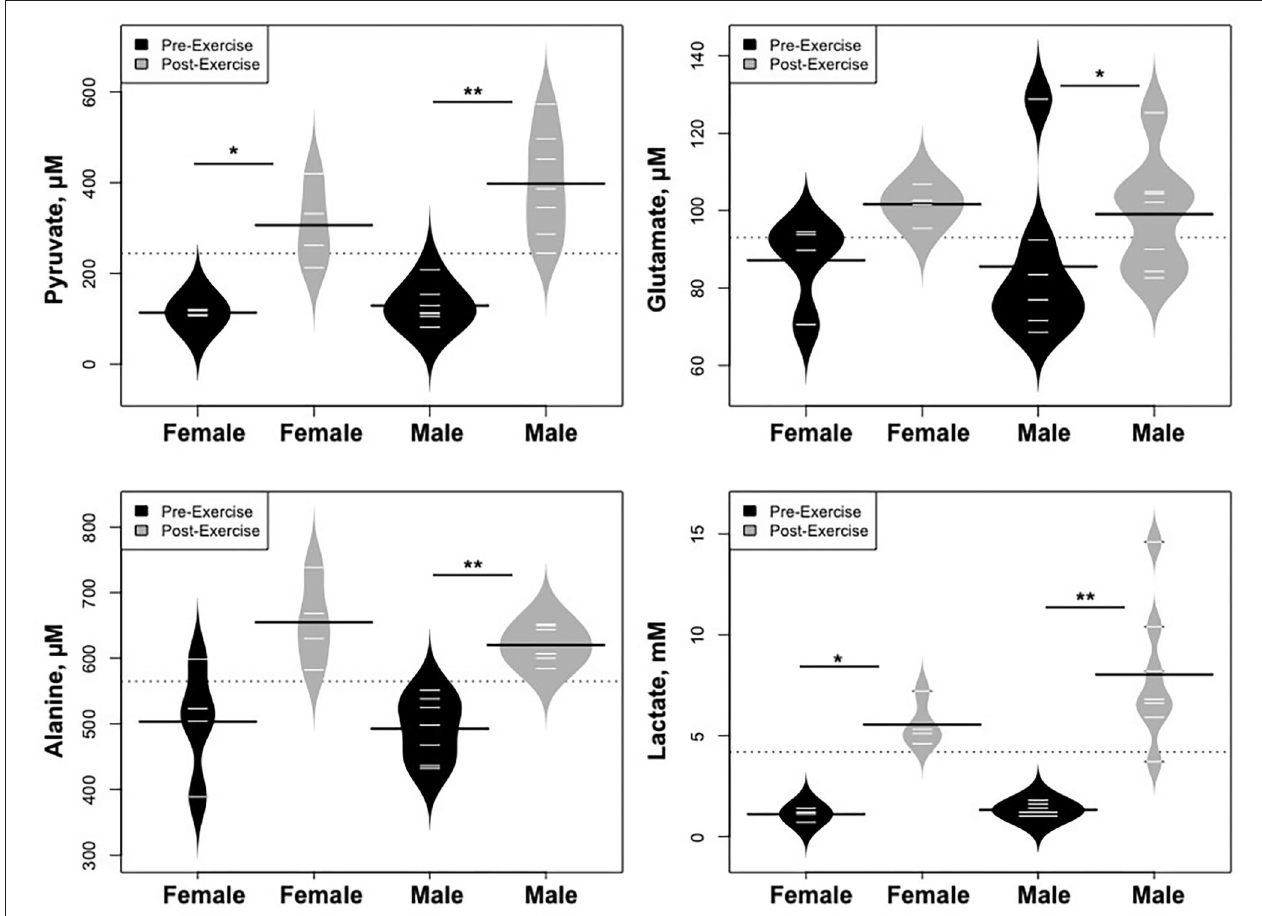
FIGURE 6 | Changes in metabolites related to interplay between the skeletal muscle and liver in maintaining blood glucose levels and disposition of the nitrogen waste through the urea cycle (Cori and Cahill Cycles), stratified by sex. * p < 0.01, ** p <